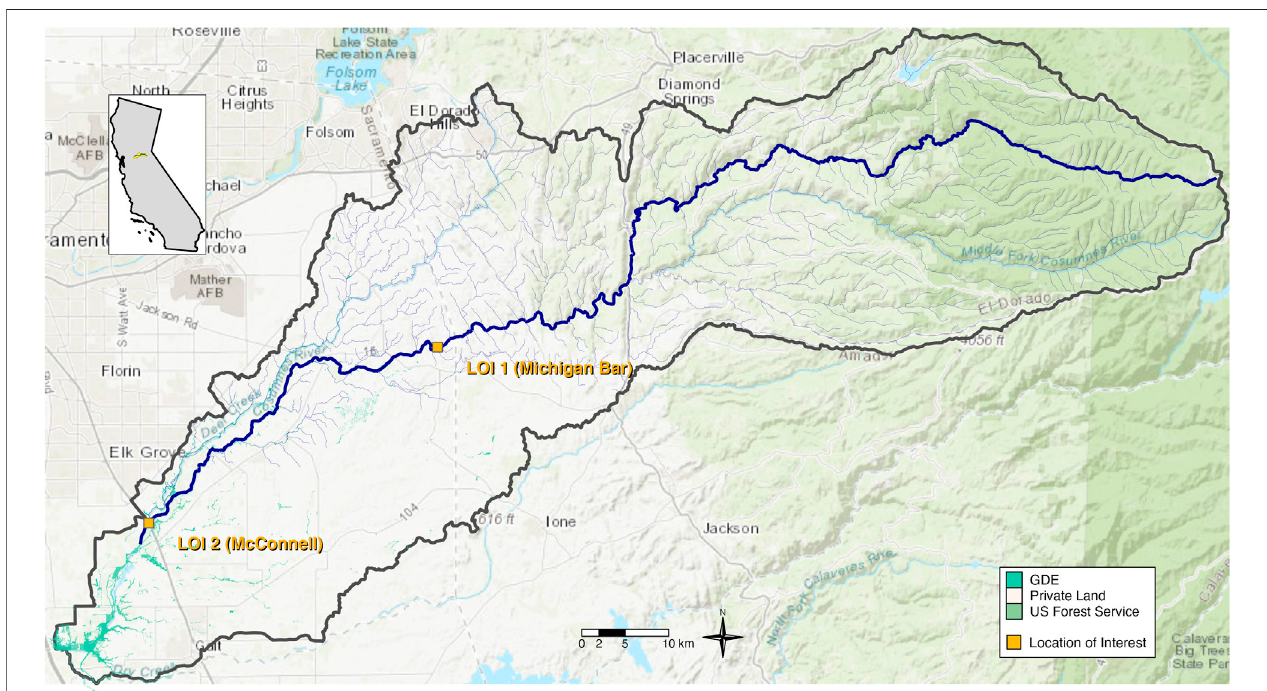
FIGURE 3 | The lower Cosumnes River watershed in Northern California. Groundwater dependent ecosystems (GDEs) are shown as green shaded polygons. Locations of interest are shown as orange squares. Background images shows topographic map with elevation contours and private versus public (US Forest Service) land designation. LOI 1 is coincident with USGS gage 11335000 in the upper reach and is currently active. LOI 2 is coincident with USGS gage 11336000 in the lower reach and is not currently active.